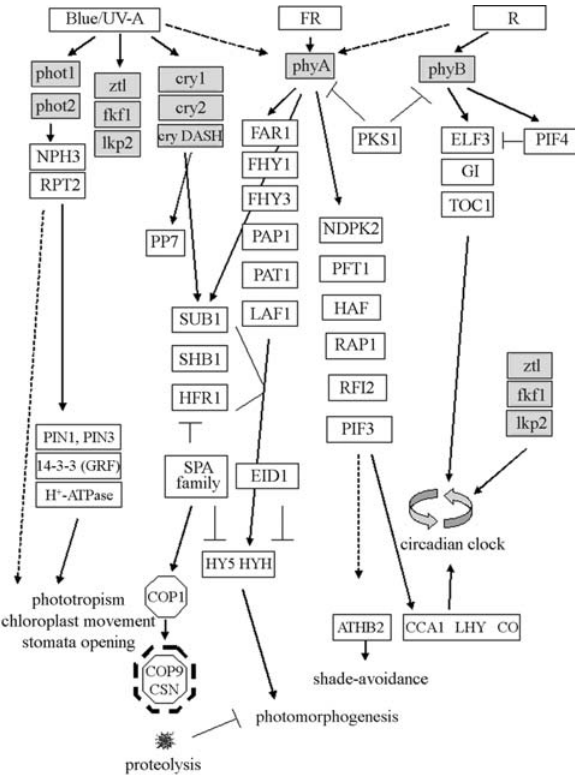
Figure 7 - Schematic overview of the photosensory signaling pathways in citrus based on comparative genomic analysis to A. thaliana . Shaded boxesrepresentphotoreceptors.Positiveandnegativeinteractionsarerep- resented by arrowheads and square ends, respectively. Dashed arrows in- dicate mechanistically undefined